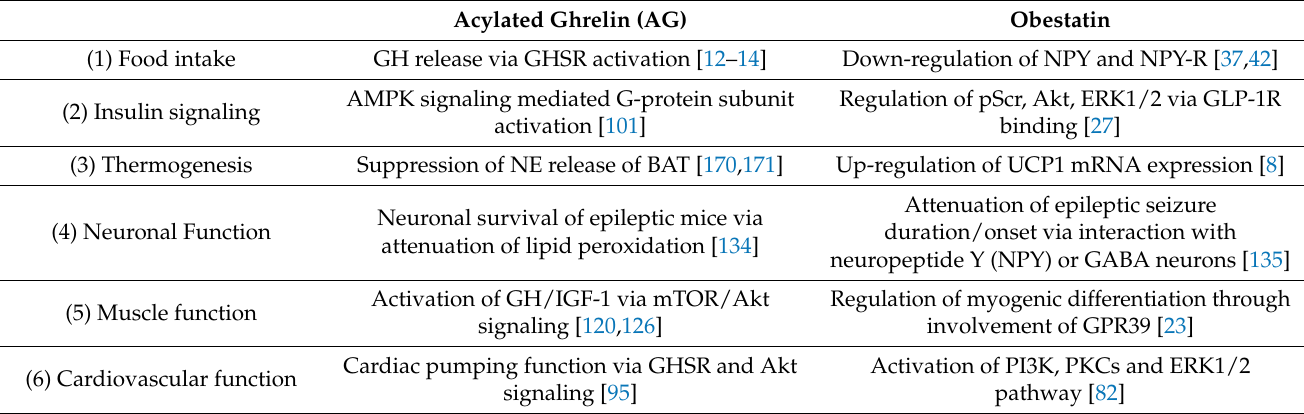
Table 1. Summary of signaling pathways of ghrelin and